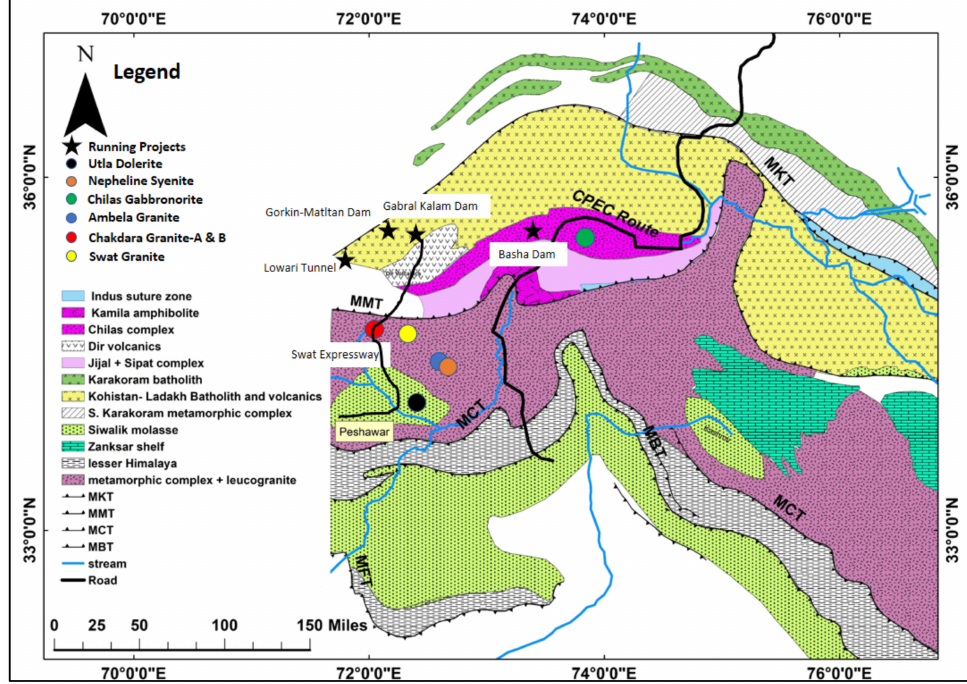
Figure 1. Geological map of northern Pakistan, modified after Searle et al. [23]. Shaded circles show the locations of the collected